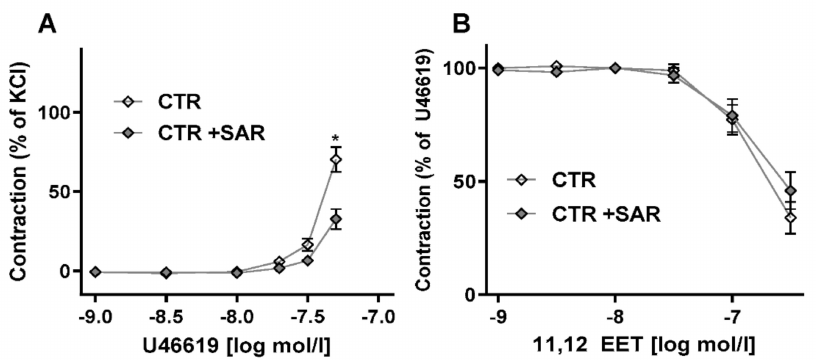
Figure 4. Effect of the Rho-kinase inhibitor SAR407899 (SAR) on U46619 contraction and EET- induced relaxation. Organ chamber experiments using aortic rings. ( A ): Constriction after U46619 stimulation with or without pre-incubation with SAR407899. ( B ): 11,12-EET-induced relaxation in U46619 preconstricted vessels incubated (+SAR) with or without SAR407899 * p < 0.05, Two-way ANOVA with Bonferroni post-test. n > 7.